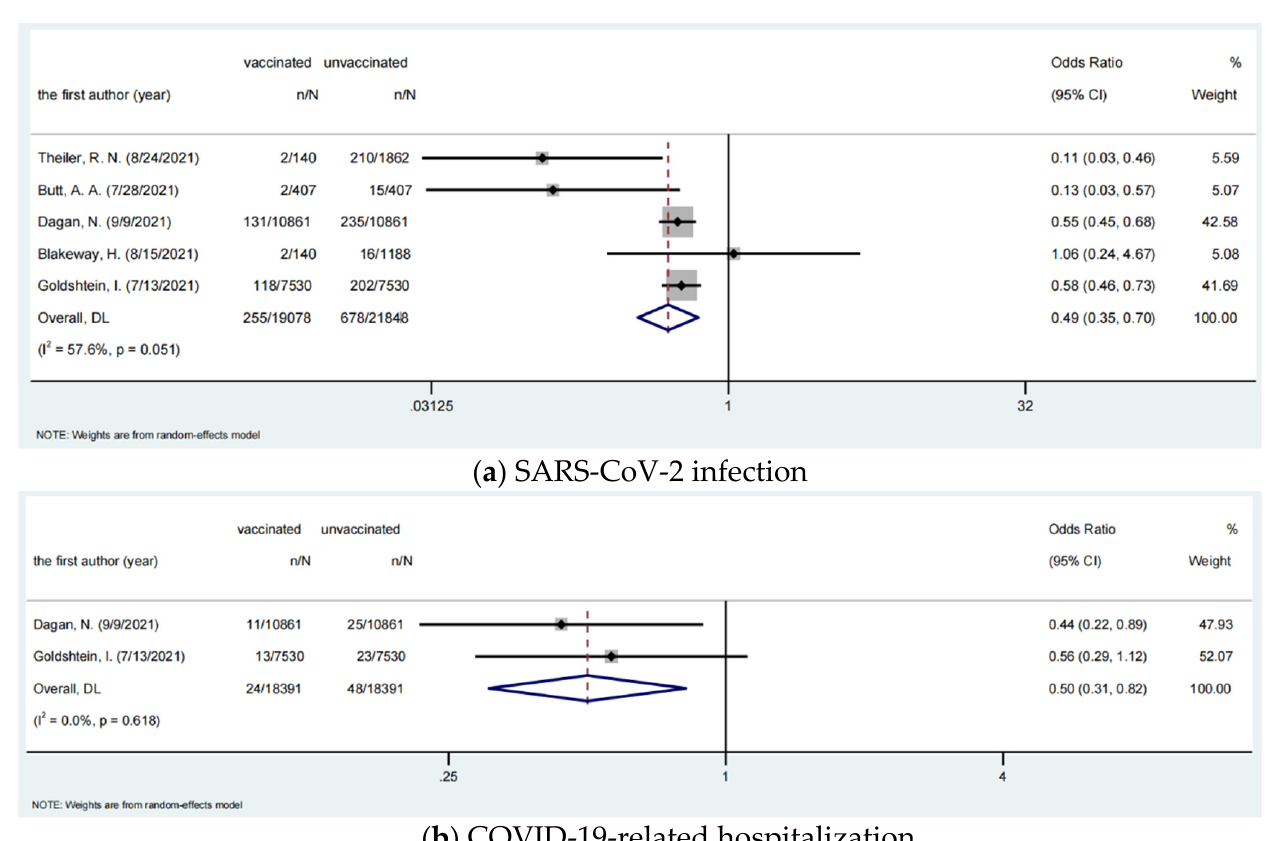
Figure 2. SARS-CoV-2 infection and COVID-19-related hospitalization incidence among pregnant women.